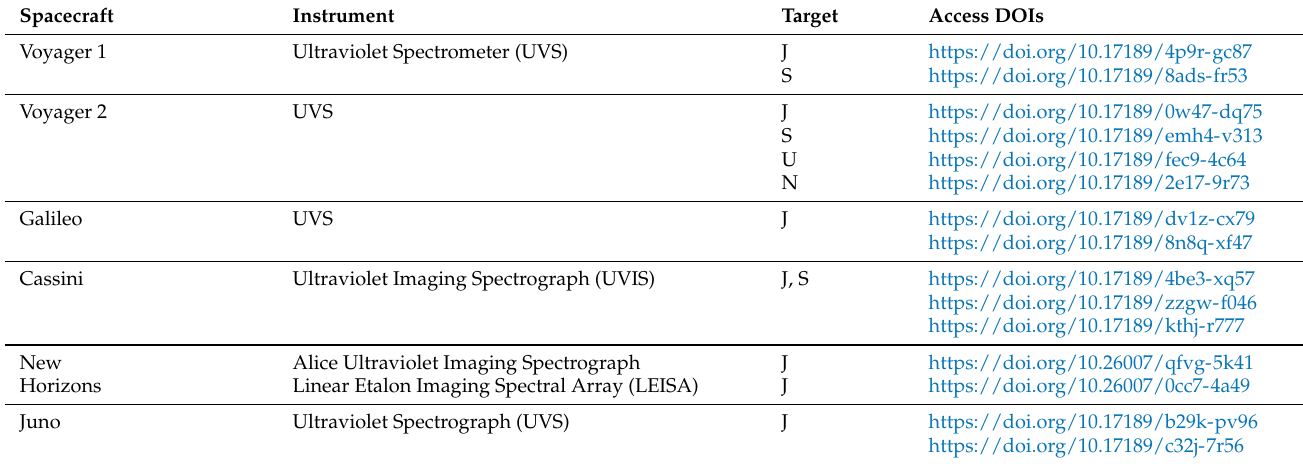
Table 2. Ultraviolet spectrometers used for remote sensing of Jupiter (J), Saturn (S), Uranus (U) and Neptune (N), and the DOIs for accessing the data. All links in this table were accessed on 30 October